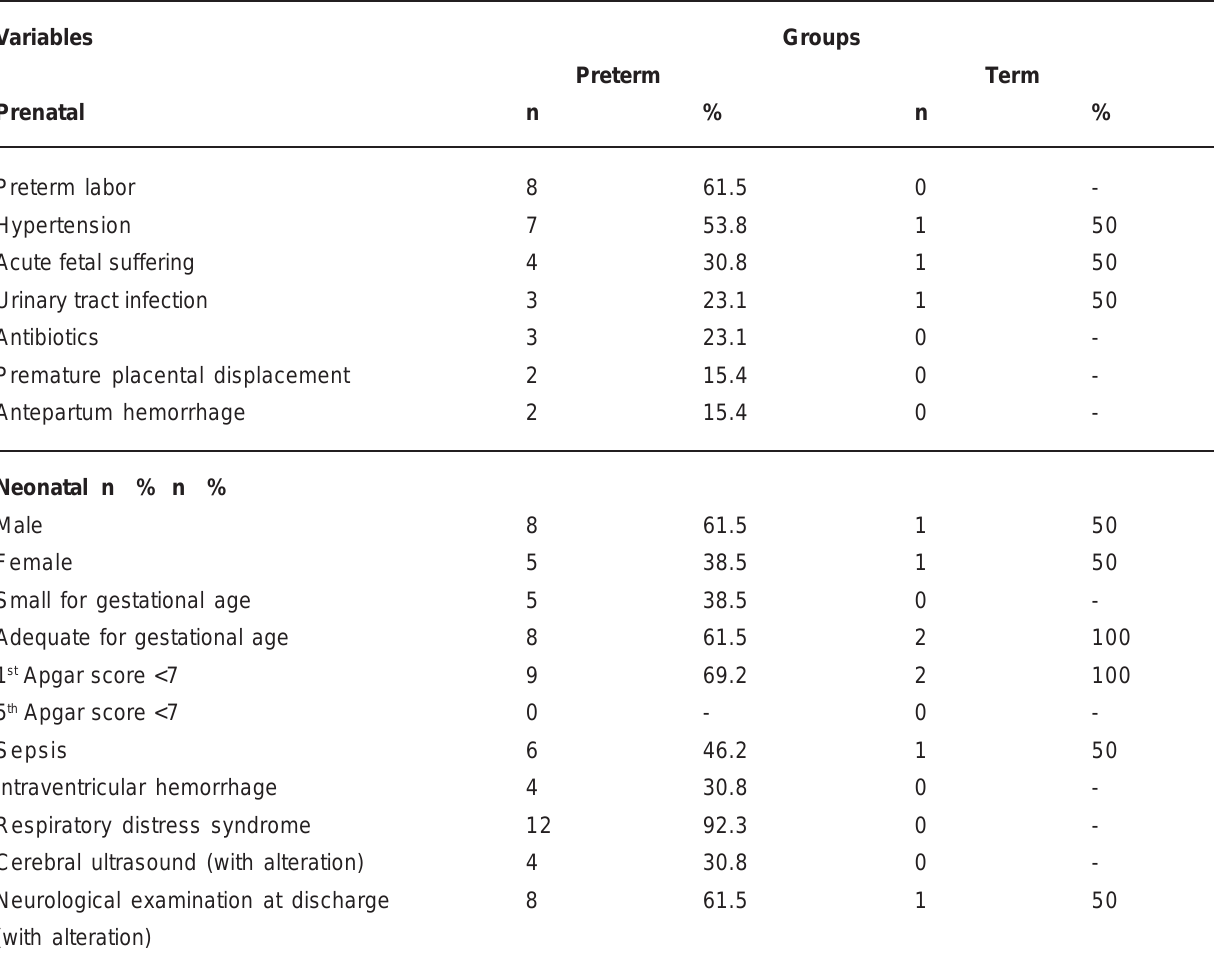
TABLE 3- Description of variables present for children with